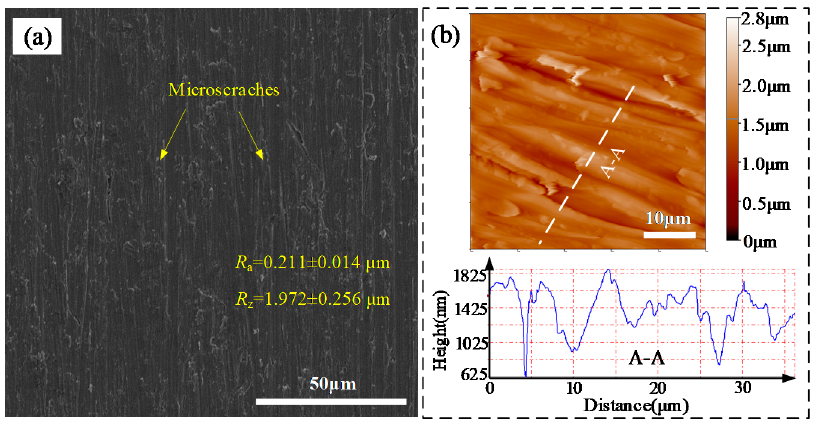
Figure 2. ( a ) SEM and ( b ) AFM morphologies of the as-received Ti–6Al–4V surface.